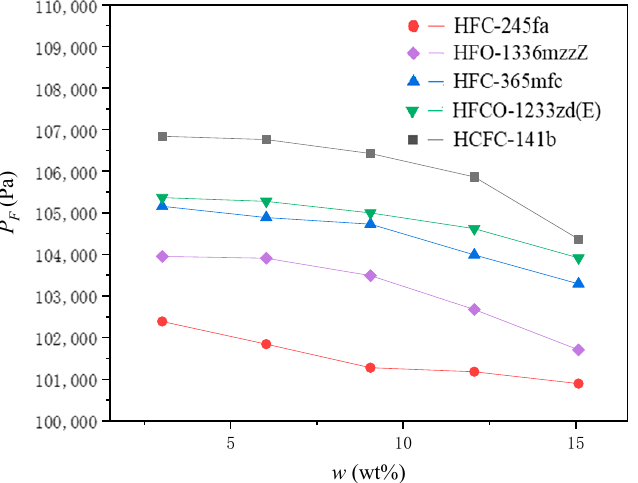
Figure 5. The relationship between the internal pressure of the foam when it stops expanding during polyurethane foaming, P F , and the initial mass ratio of the PBA to the other blending materials in the PURF, 𝑤 .